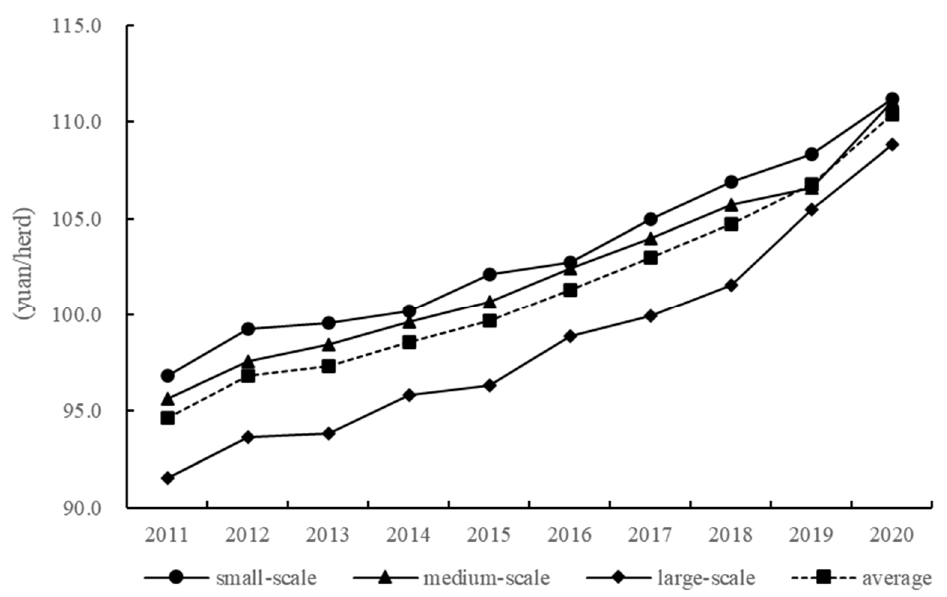
Figure 6. Annual net weight gain of hog production of different scales in China from 2011 to 2020. Table 2. The estimation results of trans-log production